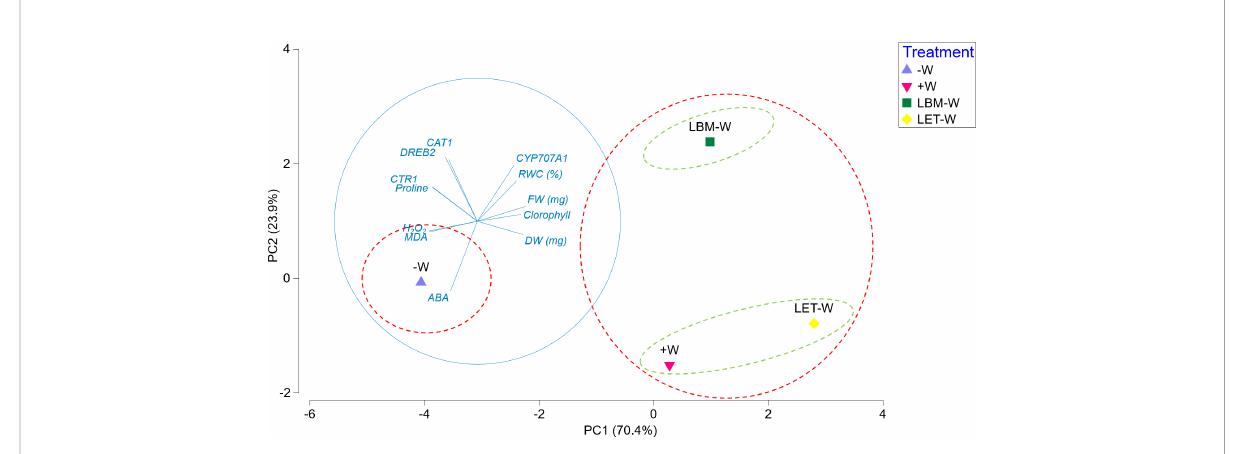
FIGURE 5 Principal component analysis plot derived from the means of all plant growth, physiological, and biochemical parameters, as well as gene expression results. Principal component axes 1 and 2 collectively accounted for 94.3% of the total variation present. Major groups are represented by red dashed circles, and minor groups are represented by green dashed